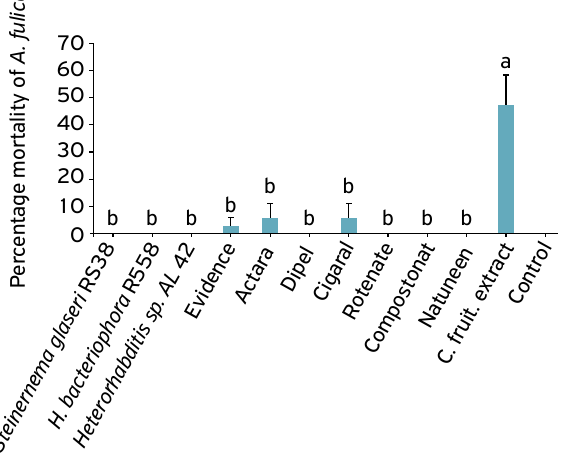
Figure 1. Percentage mortality ( ± standard error) of Achatina fulica adults treated with entomopathogenic nematodes, commercial pesticides and commercial botanical extracts and alcoholics (Tukey ≤